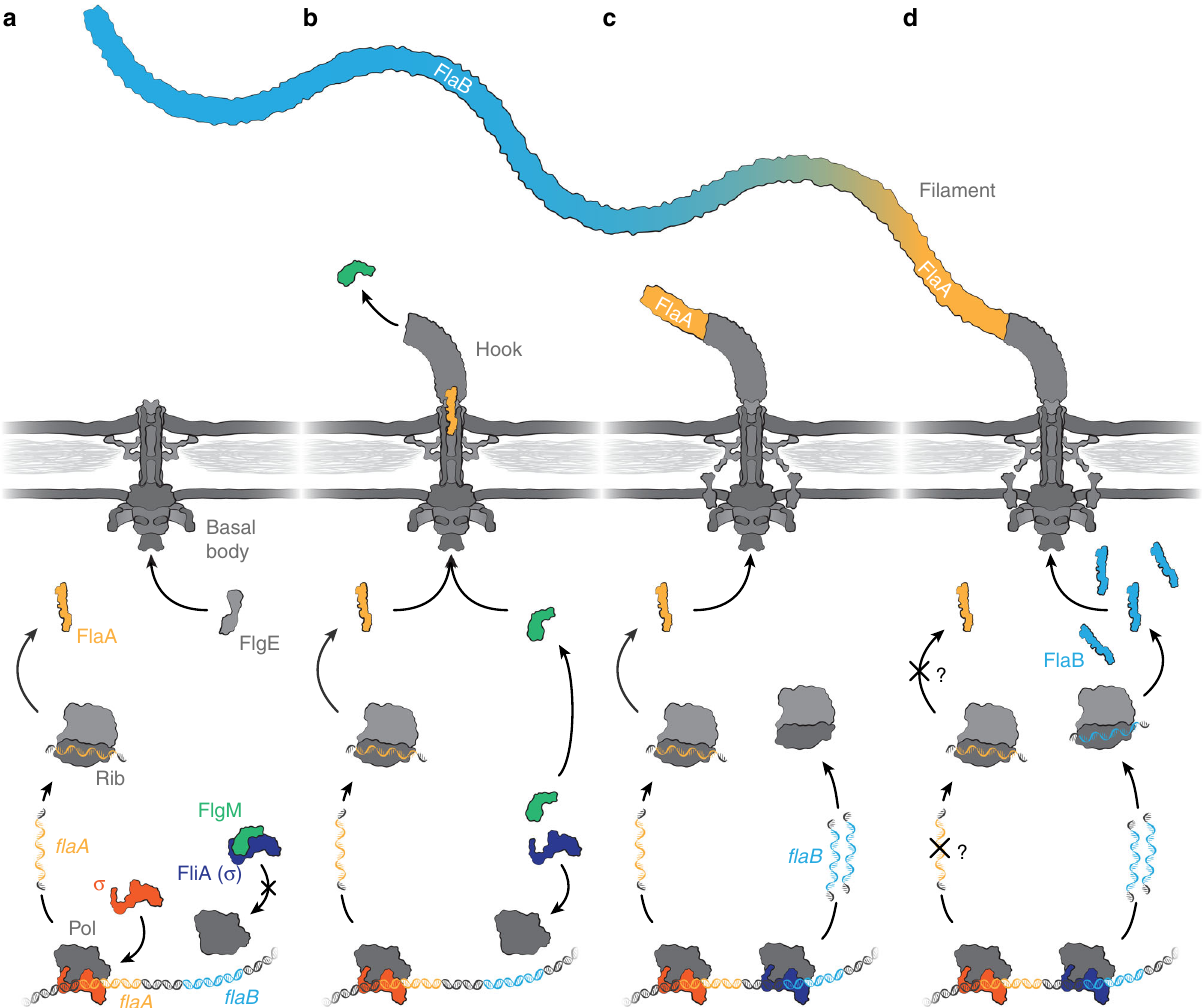
Fig. 2 Schematic model of the sequential production and export of FlaA and FlaB. The fi gure summarizes our current working model of how spatial arrangement of the two fl agellins is achieved in Shewanella putrefaciens , depicted in four subsequent stages of the fl agellar assembly. a The current model of fl agellin expression suggests that transcription is inhibited as long as the alternative sigma factor 28 (FliA) is blocked by the anti-sigma factor FlgM. In S. putrefaciens , this only applies to FlaB while FlaA production does not depend on FliA (see Supplementary Fig. 2b). Therefore, a pool of FlaA is already present while the basal body is still being assembled. b Once the hook-basal-body complex is completed the export apparatus changes its speci fi city from hook proteins (FlgE) to the fl agellins and other late assembly proteins. At this stage also the anti-sigma factor FlgM gets exported and FliA-dependent transcription of FlaB is initiated. c The already produced FlaA monomers get exported fi rst and assemble at the base of the fl agellar fi lament. d The increasing production of FlaB monomers passes that of FlaA and potentially FlaA transcription and/or translation may be reduced or even completely terminated (indicated by the question marks). Thus, FlaB constitutes the majority residual part of the fl agellar fi lament. (Pol, RNA polymerase; Rib, ribosome; σ , sigma